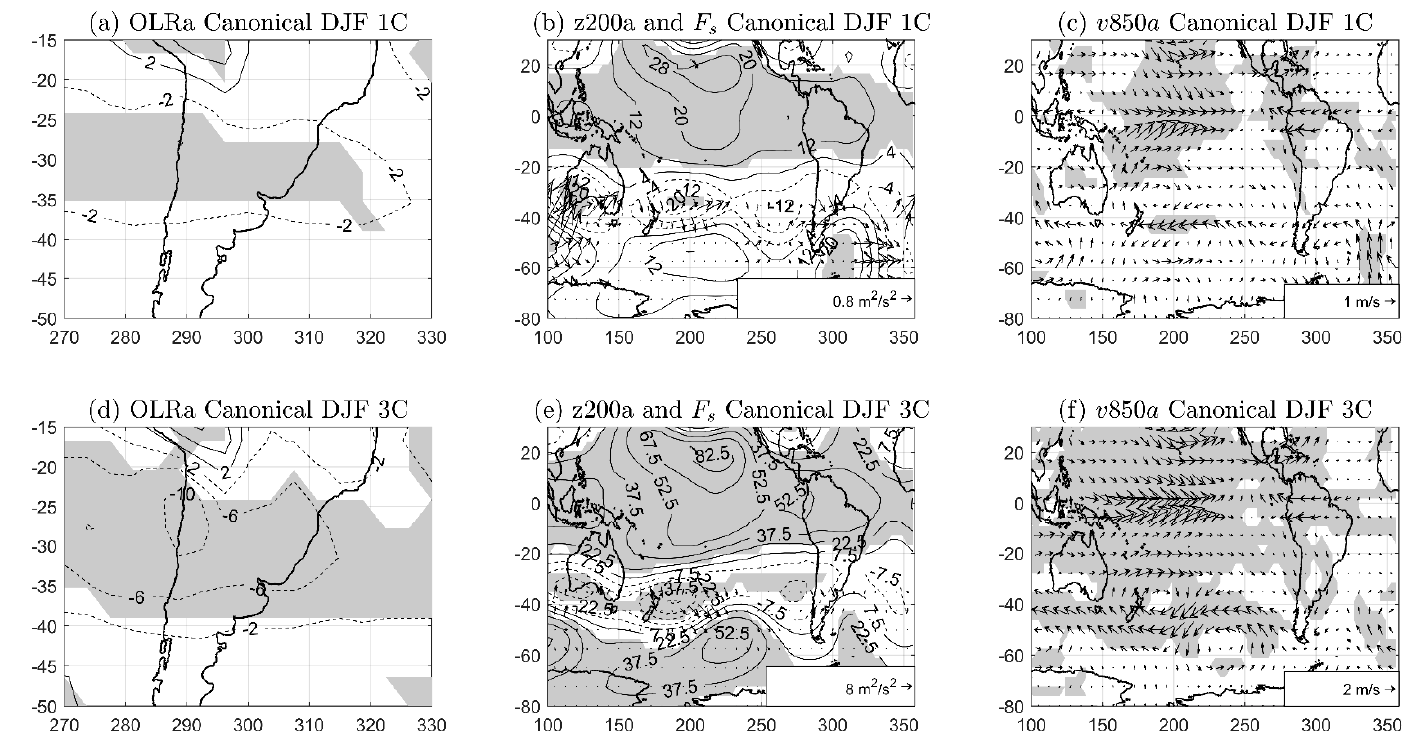
Figure 4. Model response to the Canonical El Niño 1 °C (first row) and Canonical El Niño 3 °C (second row) in ( a , d ) OLRa, ( b , e ) z200a (contours) and F s (arrows), and ( c , f ) v850a. Such response was obtained by subtracting the ensemble mean of the CONTROL experiments to the ensemble mean of the El Niño type experiments (Canonical_1C or Canonical_3C). Shaded regions exceeded the 95% level of confidence from two-tailed t -test. OLRa units: W/m 2 , z200a units: m, F s units: m 2 s − 2 and v850 units: m/s.